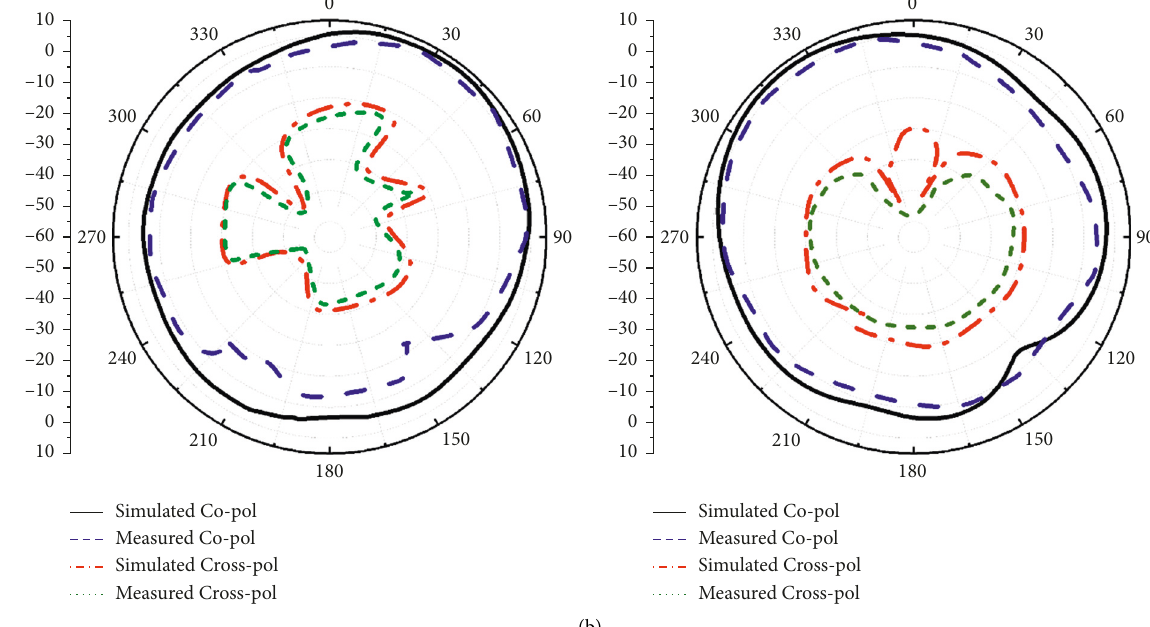
Figure 8: Antenna radiation pattern (a) 4.5GHz and (b) 5GHz.